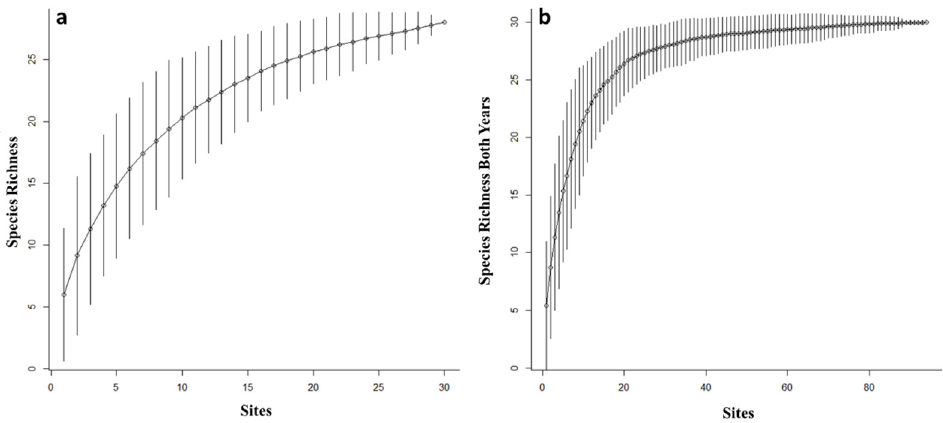
Figure 2. Species accumulation curves from bee bowl collections conducted in 2017 ( a ) and combined 2017 and 2018 ( b ) across crop and semi-natural habitat interfaces in a large-scale cotton agroecosystem.